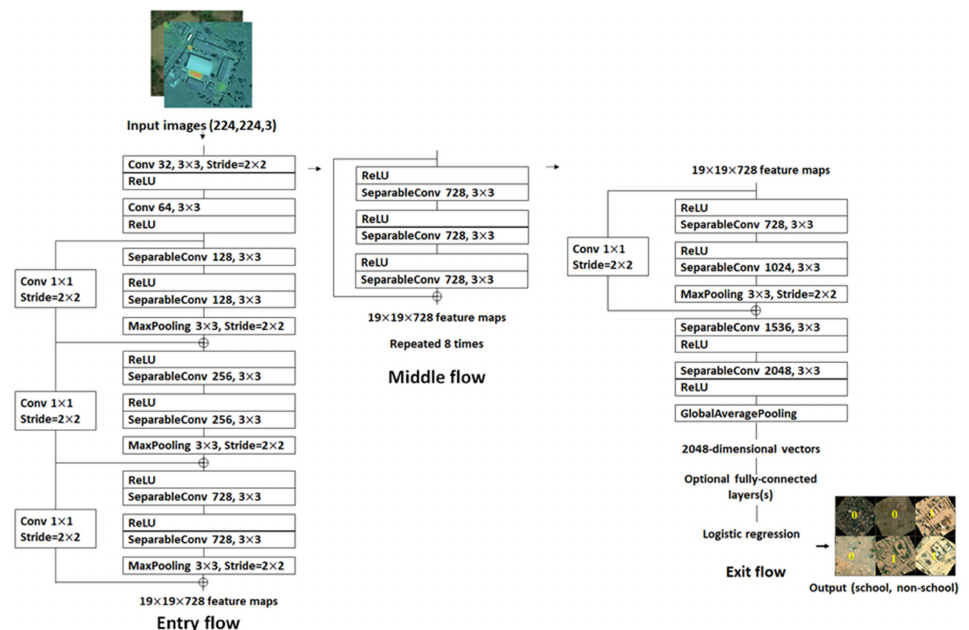
Figure 3. The Xception network architecture [57].